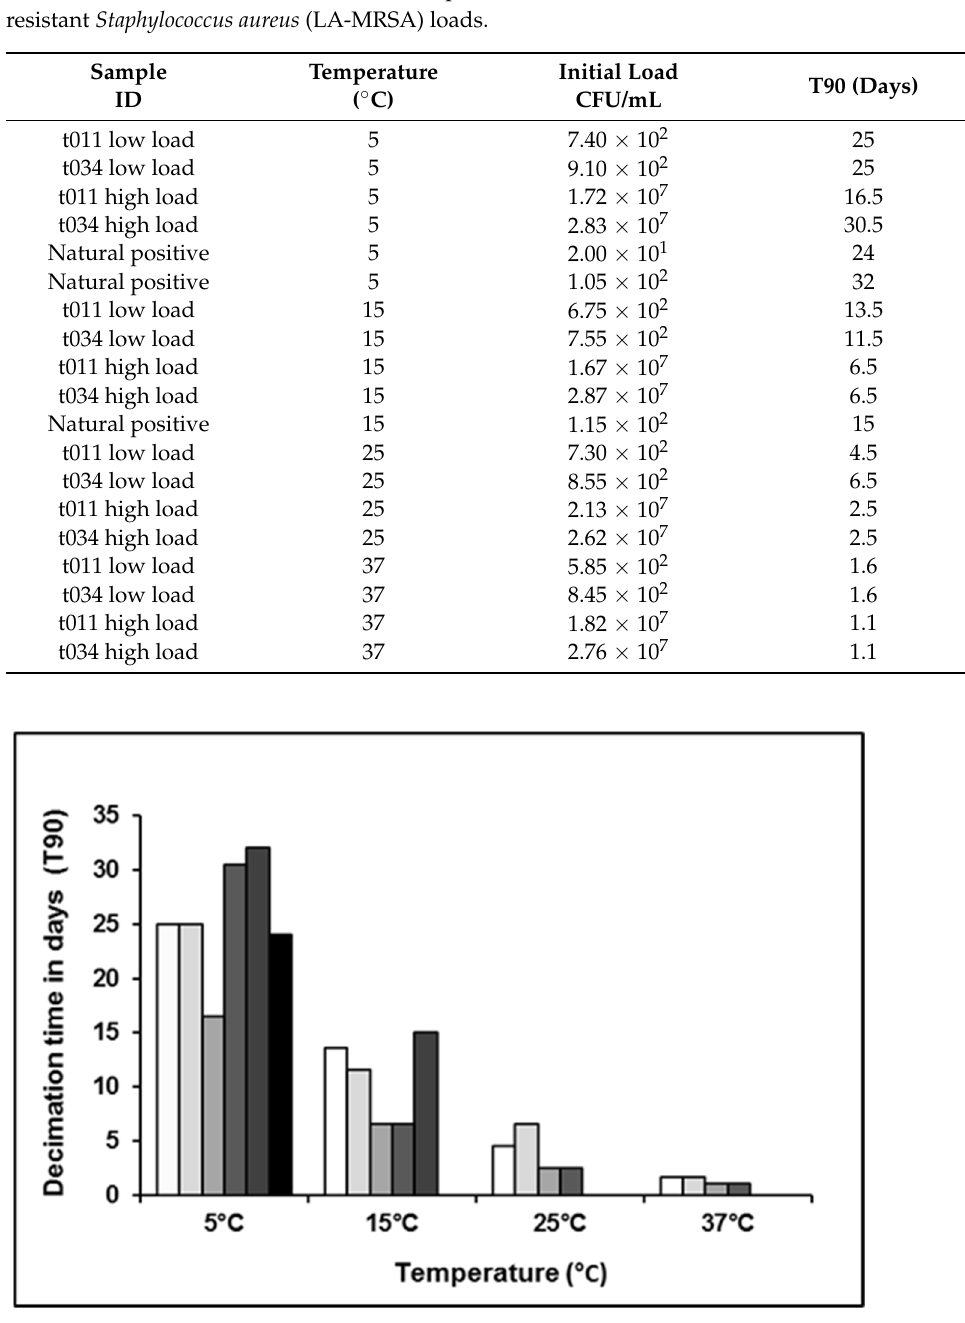
Figure 1. Decimation times of various initial LA-MRSA loads at different temperatures. The survival curves for LA-MRSA in both natural positive and spiked manure samples are shown in Figure 2. Closed square = t034 107 CFU/mL, open square = t011 107 CFU/mL, closed triangle = t011 102 CFU/mL, open triangle = t034 102 CFU/mL. Figure 2 A is at 5 °C, closed circle = natural pos. sample 20 CFU/mL, open circle = natural sample 100 CFU/mL. Figure 2 A1, 5 °C, is a close-up of low levels from Figure 2 A. Figure 2 B is 15 °C, circle closed = natural sample 100 CFU/mL. Figure 2 C is 25 °C and Figure 2 D 37 °C. With a high spiking level the decay of LA-MRSA, until decimation time, at 5 °C could be explained by exponential regression, whereas the decay at 15, 25, and 37 °C could be explained by linear regression. The decay in samples with low spiking, irrespective of temperature, was less predictable and could not be described by either linear or exponen- tial regression. At 5 °C LA-MRSA was stable until Day 7, whereas an initial slight increase in LA-MRSA was observed at 15, 25, and 37 °C, before a continuous decay of LA-MRSA could be detected (Figure 2).